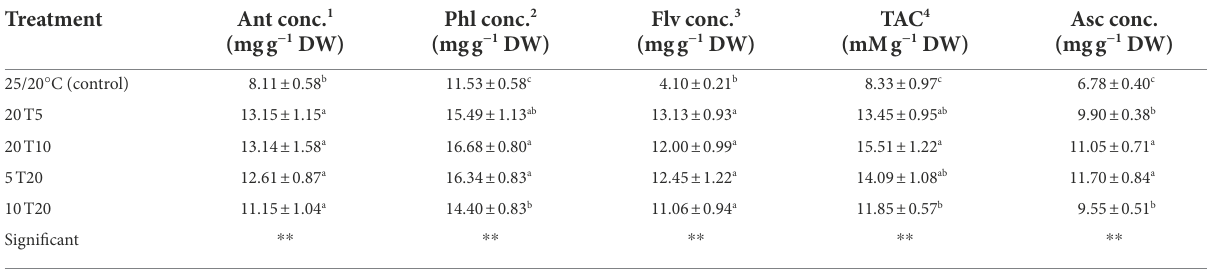
TABLE 5 Anthocyanin (Ant conc.), total phenolic (Phl conc.), and total flavonoid (Flv conc.) concentrations, as well as total antioxidant capacity (TAC), and ascorbic acid (Asc conc.) concentration of amaranth seedling leaves treated with different short-term root-zone temperatures (RZT) for 3 days (Experiment